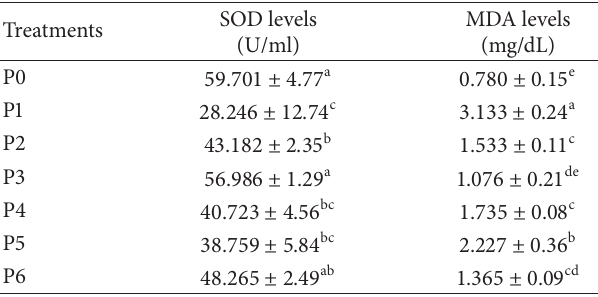
Table 3: Level of SOD and MDA of blood serum of diabetic rats treated with or without various salacca